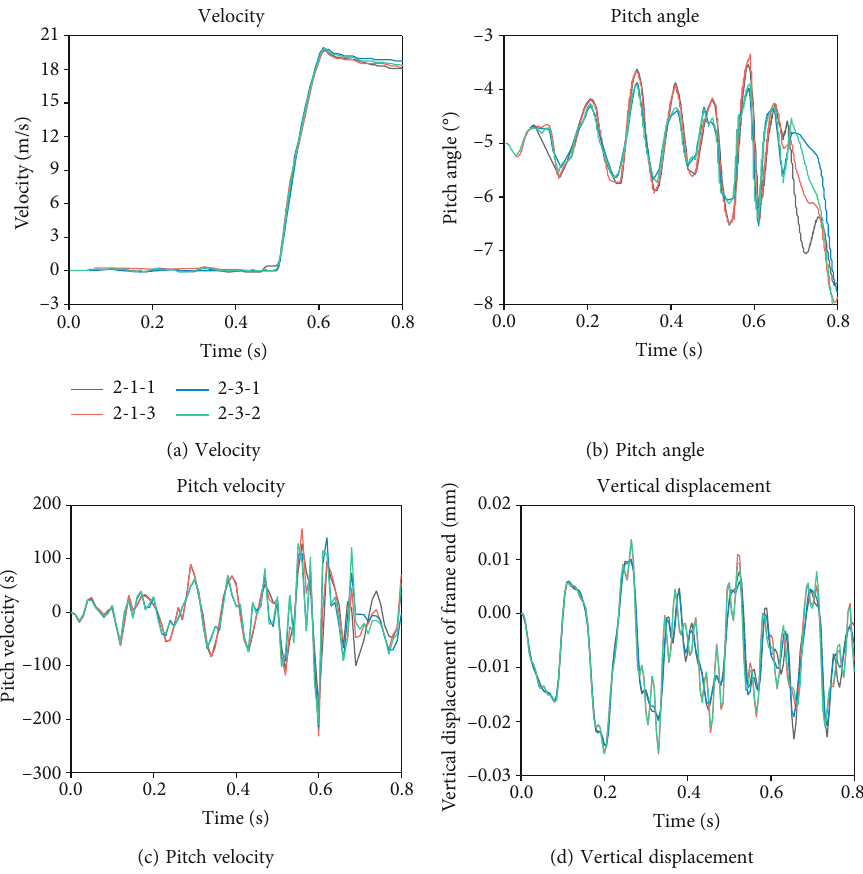
Figure 13: Comparison of missile movement under di ff erent loading units.